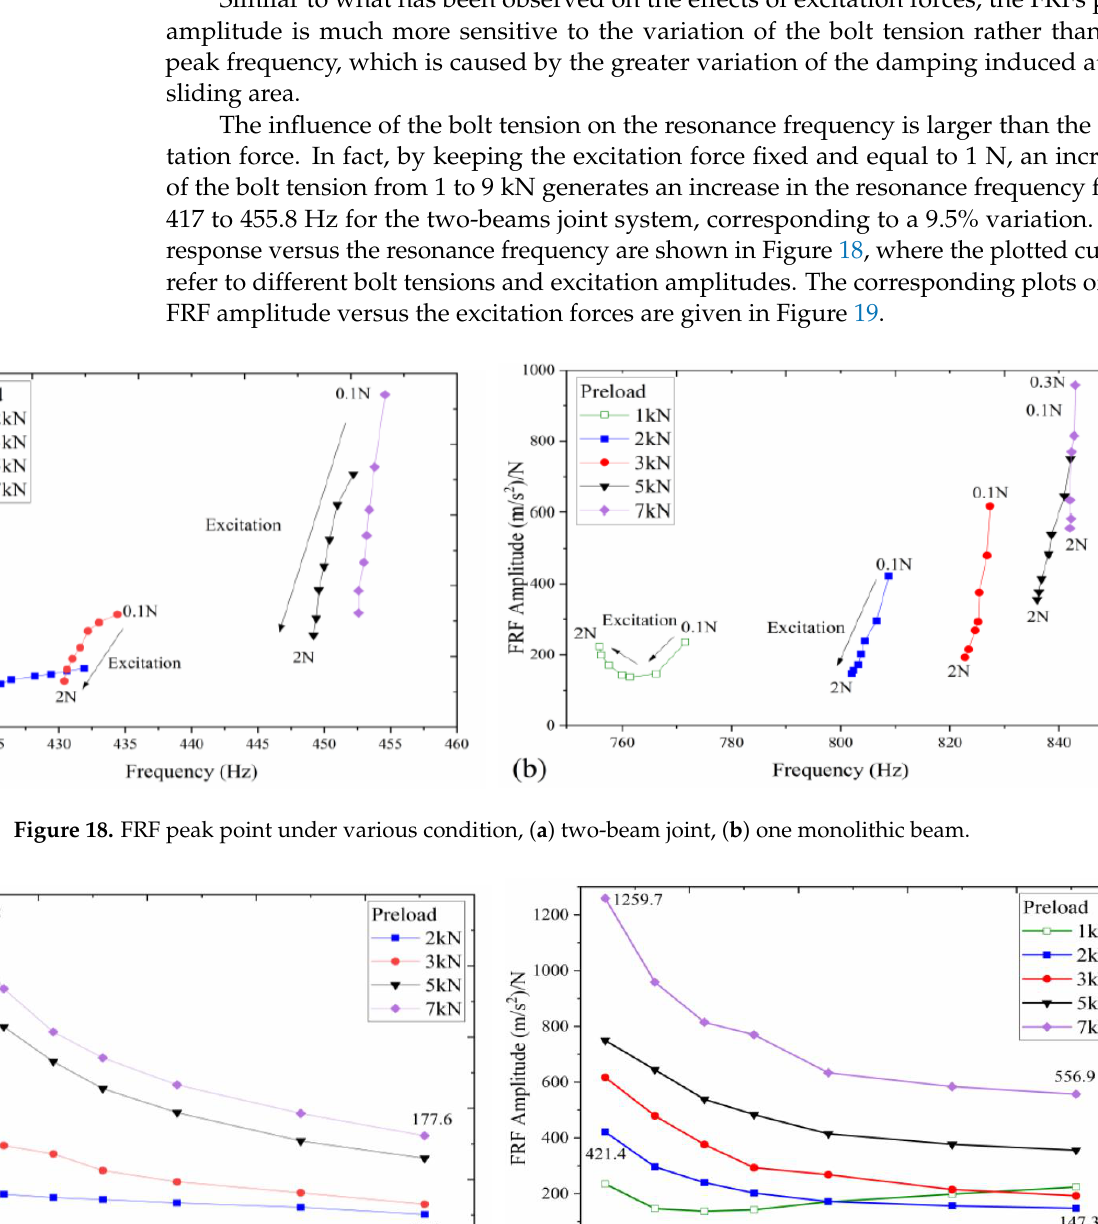
Figure 17. Contact pressure of interfaces under, ( a ) small bolt tension (1 kN), ( b ) large bolt tension (7 kN).